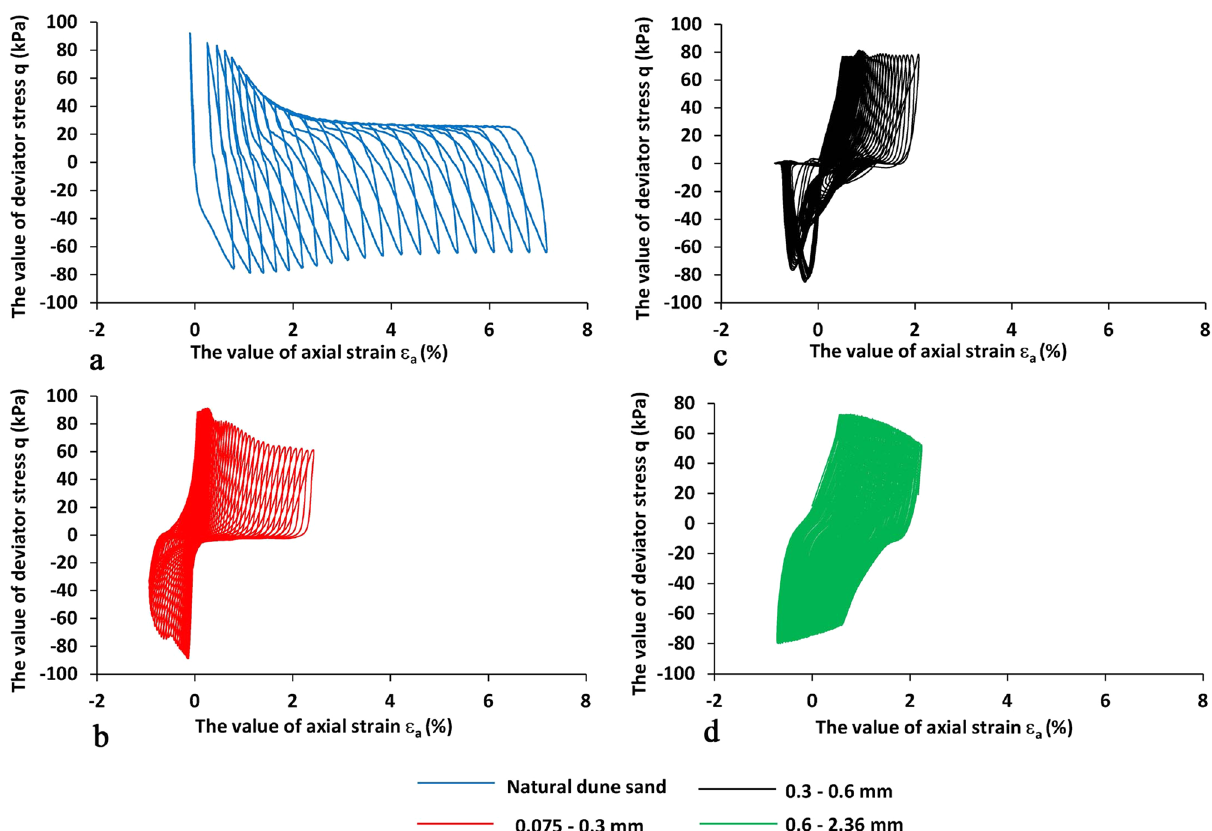
Figure 7. The deviator stress (q, kPa) vs. the value of axial strain ε a (%, positive is compression) number of vibration cycles N cyc for four sand samples under study, the X-values is the value of axial strain ε a (%,), the Y-axis is the value of deviator stress (kPa). The blue, green, black, and red lines are for natural dune sand, fractions 2.36–0.6, 0.6–0.3, 0.3–0.075 mm,